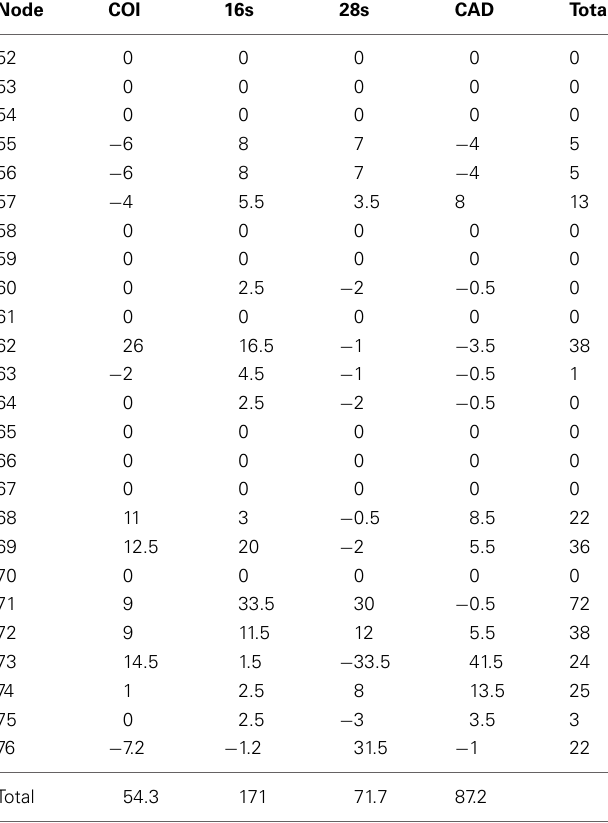
Table 4 | Partition bremer support for 1 of 87 most parsimonius trees reconstructed with the manually aligned data (Figure